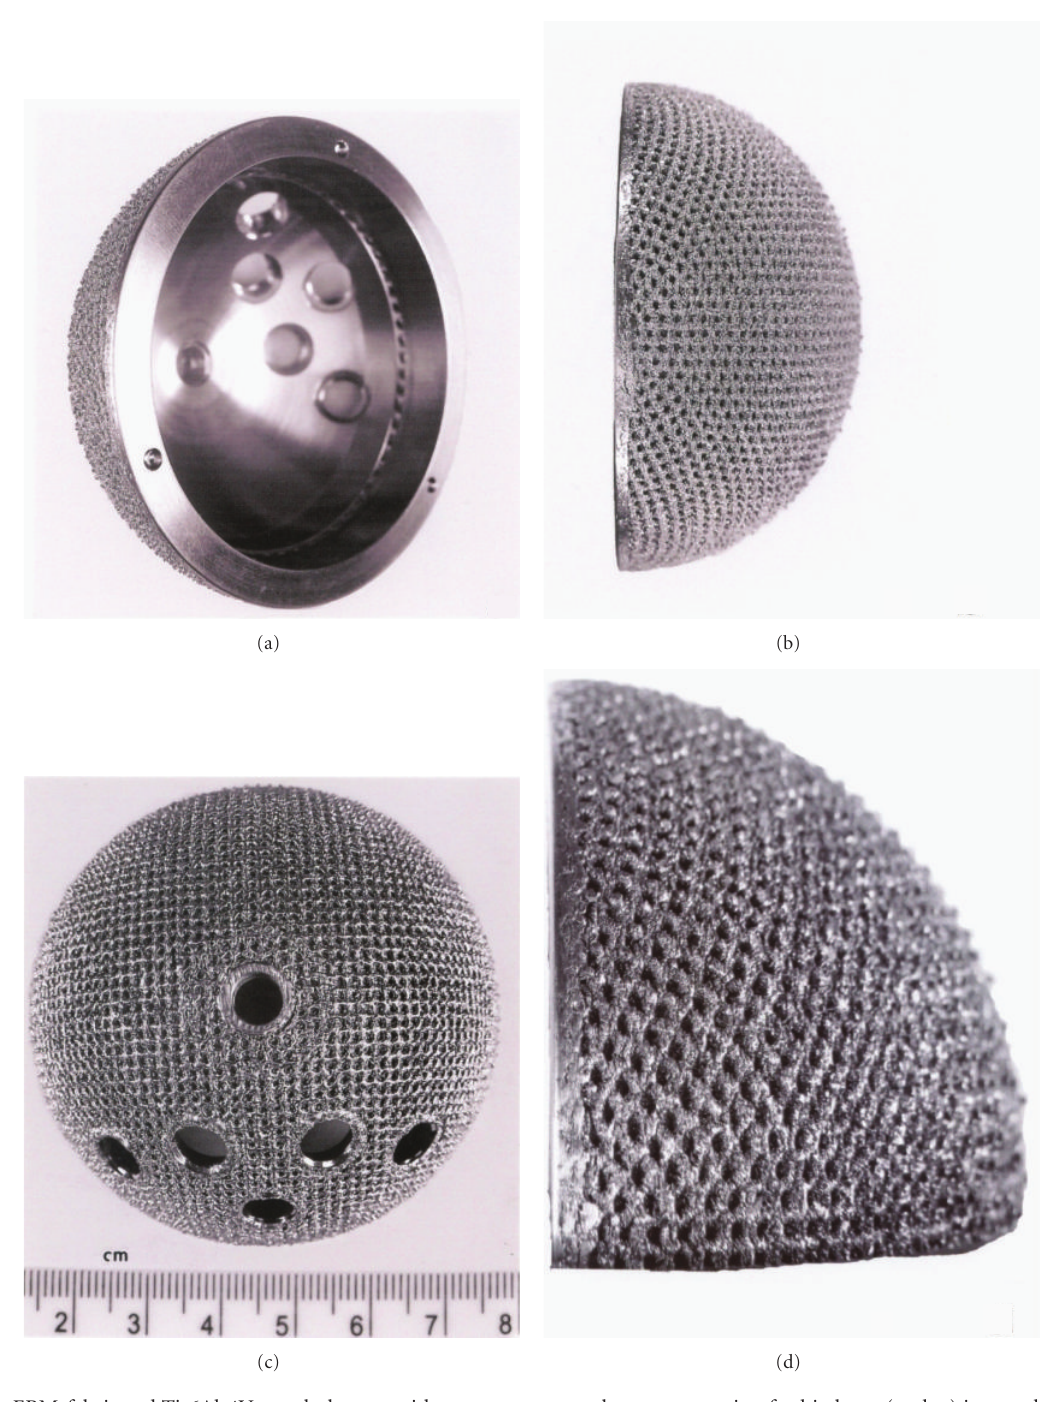
Figure 13: EBM-fabricated Ti-6Al-4V acetabular cup with outer porous-mesh structure region for hip bone (socket) ingrowth. (a) and (b) show rotated views while (c) and (d) show magnified sections illustrating the porous-mesh structure (sample courtesy of Arcam).